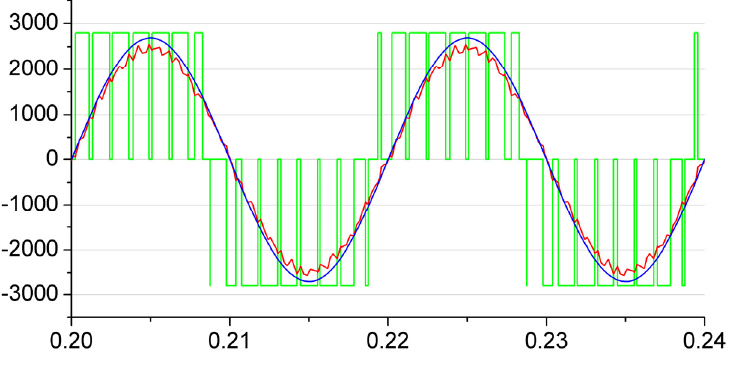
Figure 9. Simulation outputs of 3L-NPC inverter under rated normal operation (output voltage pulses-green, grid voltage-blue, phase current-red, V DC bus voltage V = 1 p.u.). DC